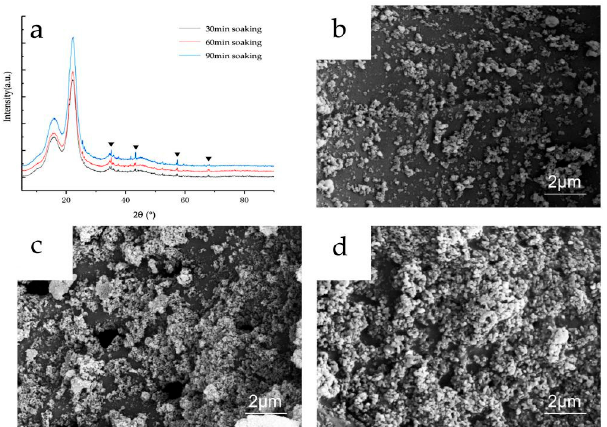
Figure 4. ( a ) XRD patterns of di ff erent soaking time: 30 (black), 60 (red), and 90 min (blue); high-magnification SEM images of chitosan / sodium phytate / nano-Fe 3 O 4 composite coatings on wood surfaces obtained by di ff erent soaking time: ( b ) 30 min, ( c ) 60 min, and ( d ) 90 min.